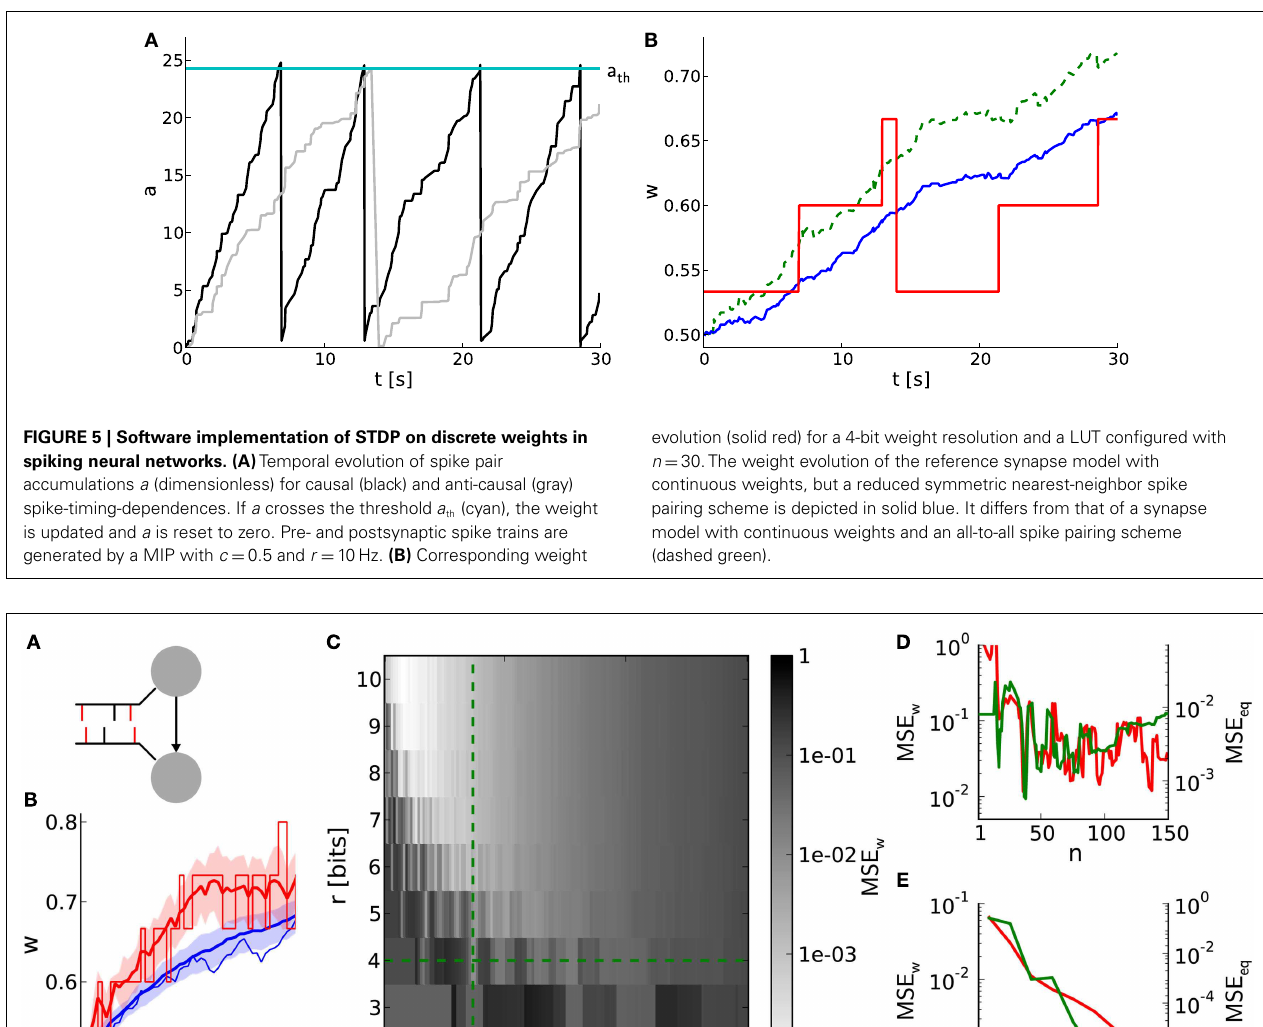
correlation coefficient c = 0.2, an initial weight w 0 = 0.5 and firing rates of 10Hz.The results persist qualitatively for differing values staying within biologically relevant ranges (not shown here). (C) Mean squared error MSE w between the mean weight traces as shown in (A) over the weight resolution r and the number n of SSPs.The parameters c , w 0 , and the firing rates are chosen as in (B) . Other values for c and w 0 do not change the results qualitatively. (D,E) Cross sections of (C) at r = 4 bits and n = 36 in green. Red curves are adapted from Figures 4C,D